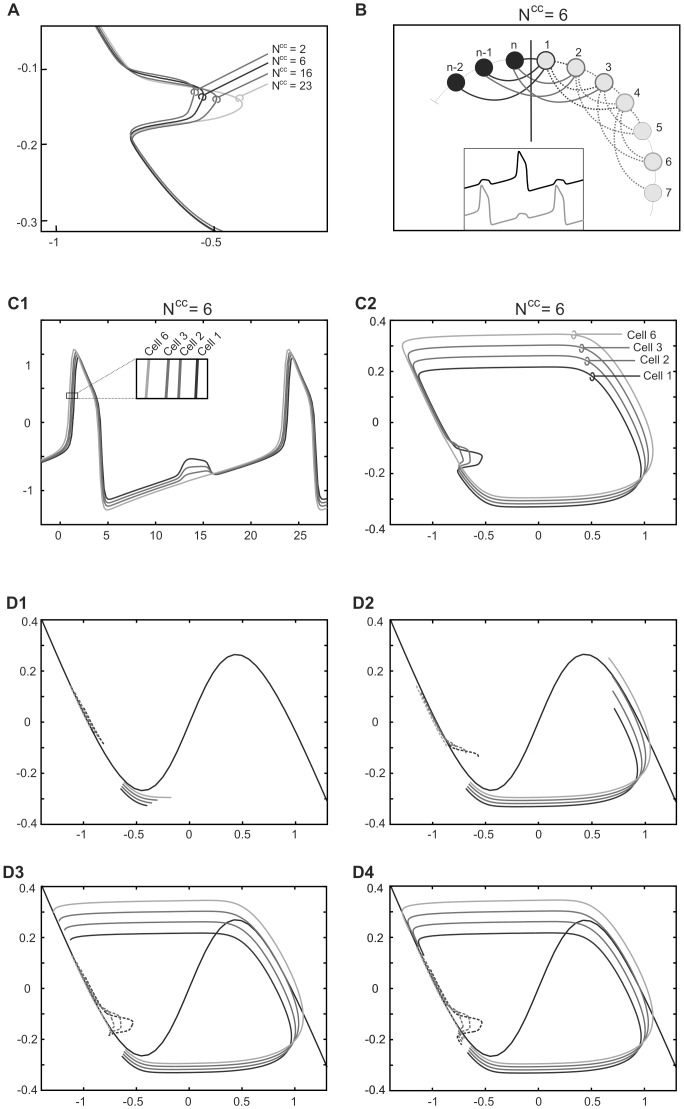
Effect of network connectivity on the trajectory of cells expressing AP pattern.A. Deflection of cells trajectory resulting from interaction with the active cells for different connectivity parameter (Ncc). B. Wiring diagram of connectivity for Ncc = 6. Shown are connections close to the border between two groups of cells (vertical line) (see also voltage traces in insert). C. Voltage traces (C1) and phase plane trajectories (C2) of cells belonging to one of the groups. Shown are same cells as in B. D. Consecutive steps of phase plane evolution (D1-D4) of the two groups of cells (solid and dashed lines). Shown are the same cells as in C and analogous cells from the other group. Parameters: N = 24, gel = 0.22 (A, C-D). Phase plane coordinates: V (abscissa), W (ordinate) (A, C2, D).